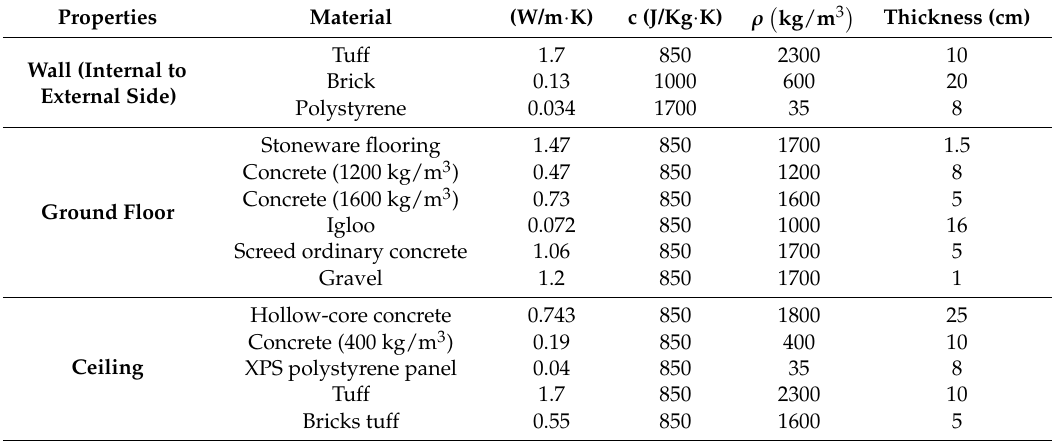
Table 2. Thermo-physical properties of building